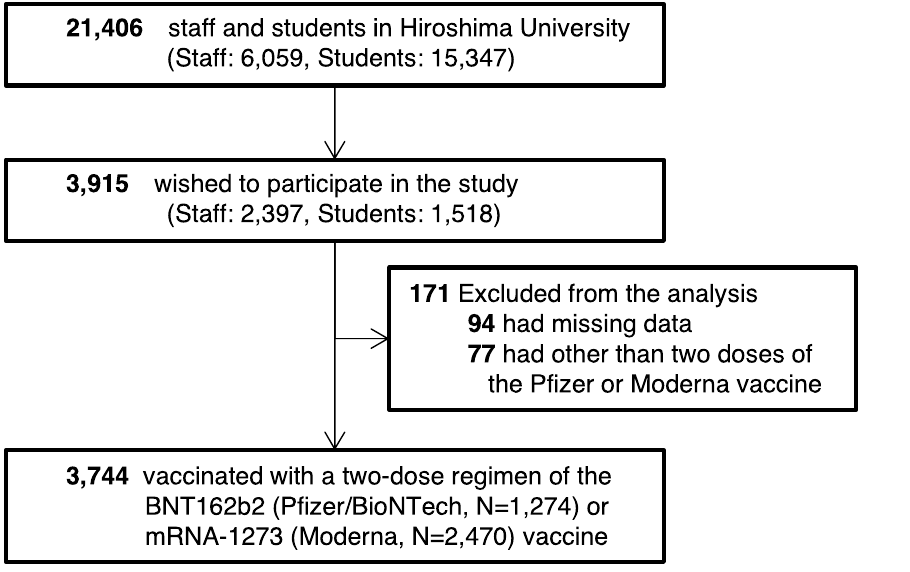
Figure 1. Study population of vaccinated healthy